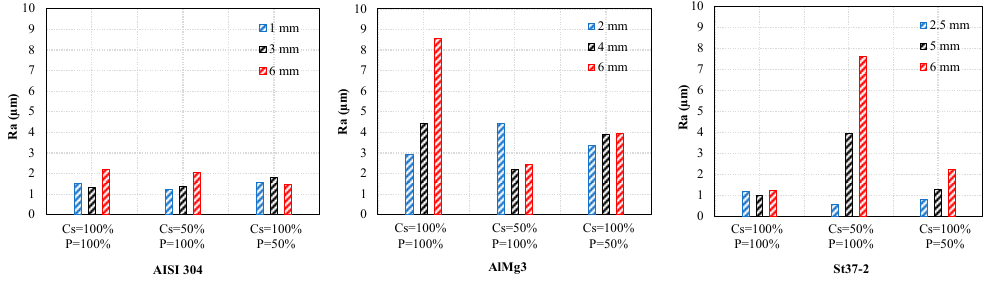
Figure 17. Arithmetic mean surface roughness.